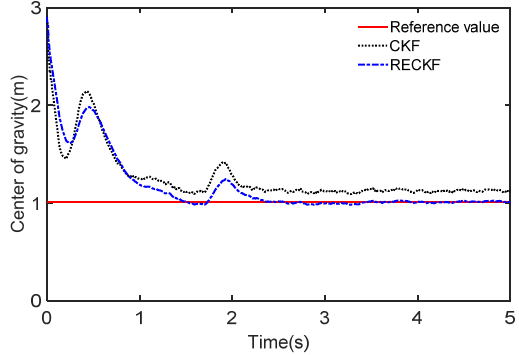
Figure 8. The estimated CG in the case of acceleration. Table 4. The RMSE in the case of acceleration.